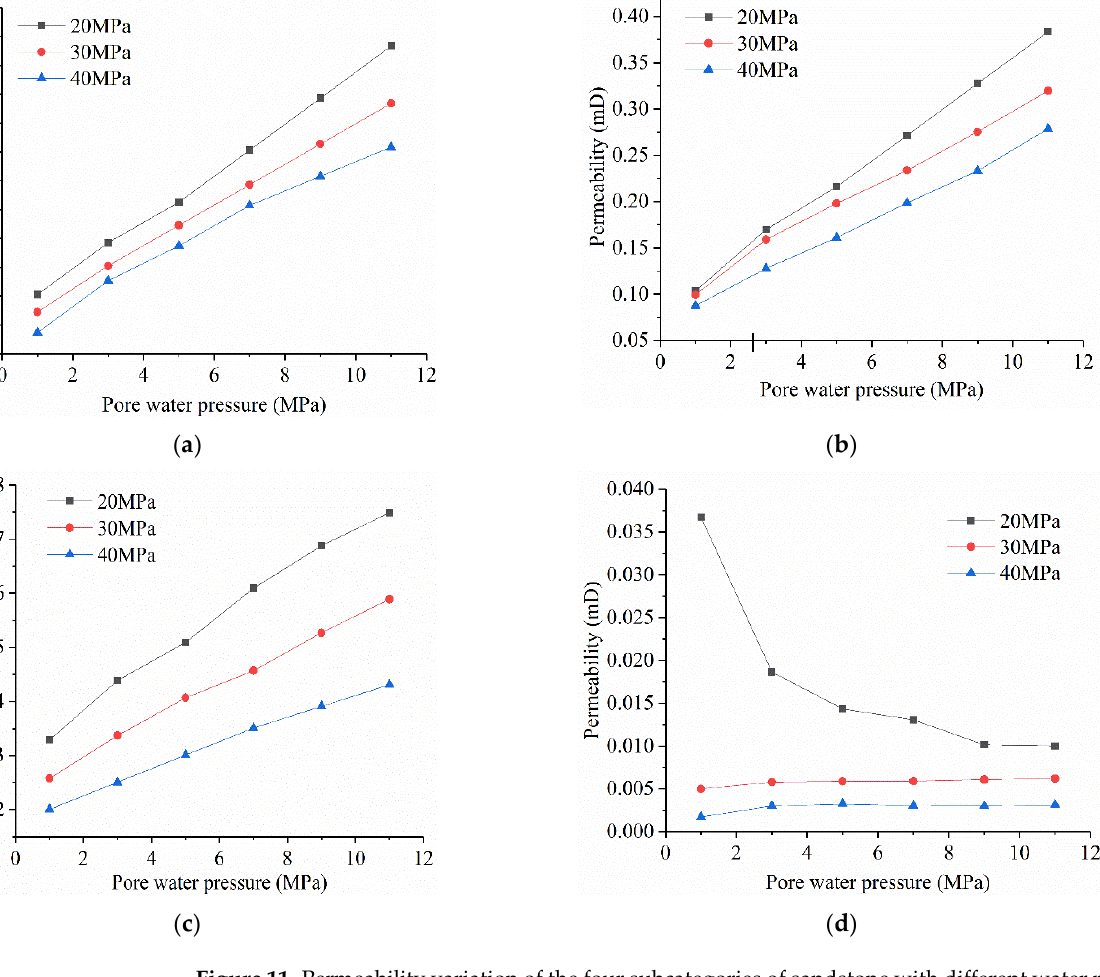
Figure 11. Permeability variation of the four subcategories of sandstone with different water pressure: ( a ) subcategory Ι 1 sandstone; ( b ) subcategory Ι 2 sandstone; ( c ) subcategory II 1